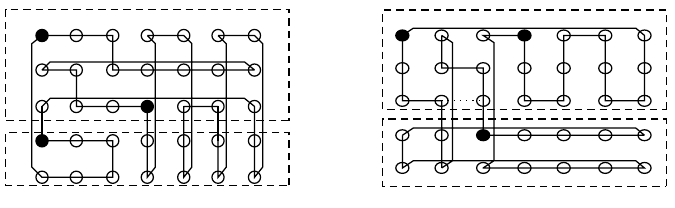
H T k = 3). 5 , 7 ( 1 in